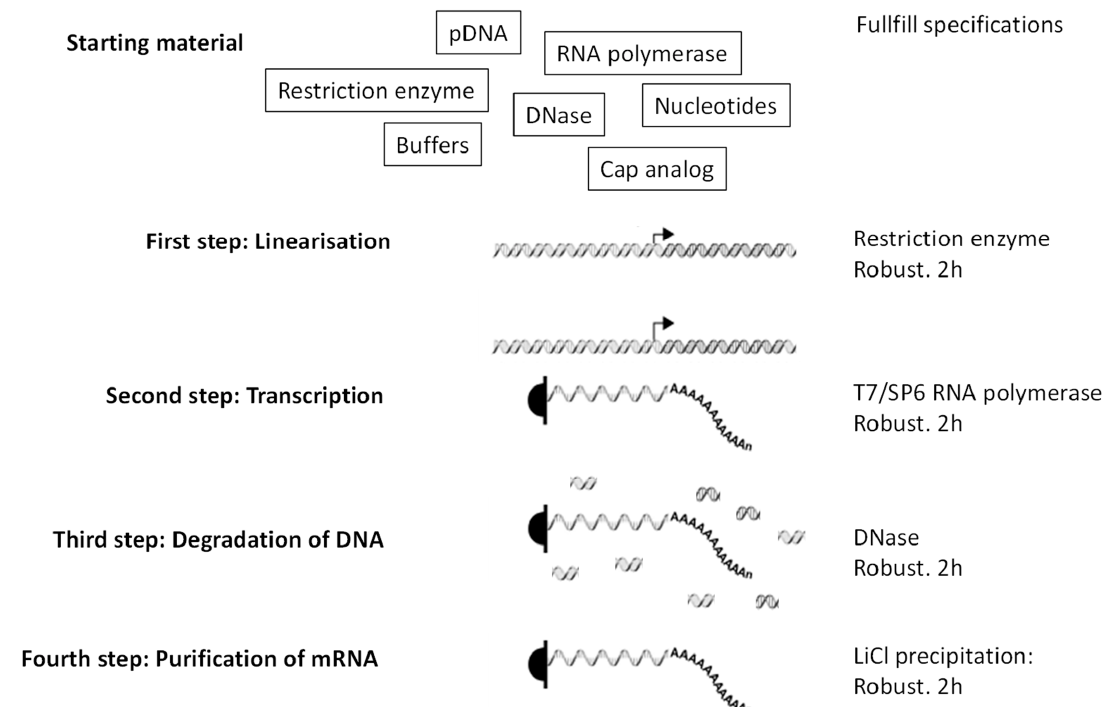
Figure 2. Production of ivt mRNA. Little starting material is needed. Then the four steps are all robust (work independently of the sequence of the ivt mNA needed) and take only a few hours each (each step takes 2 h in the lab). Right arrow is a promoter recognized specifically by the RNA polymerase.